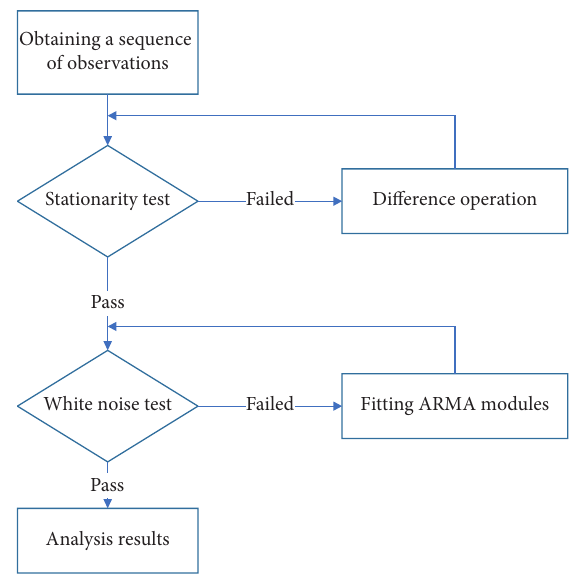
Figure 4: ARMA model